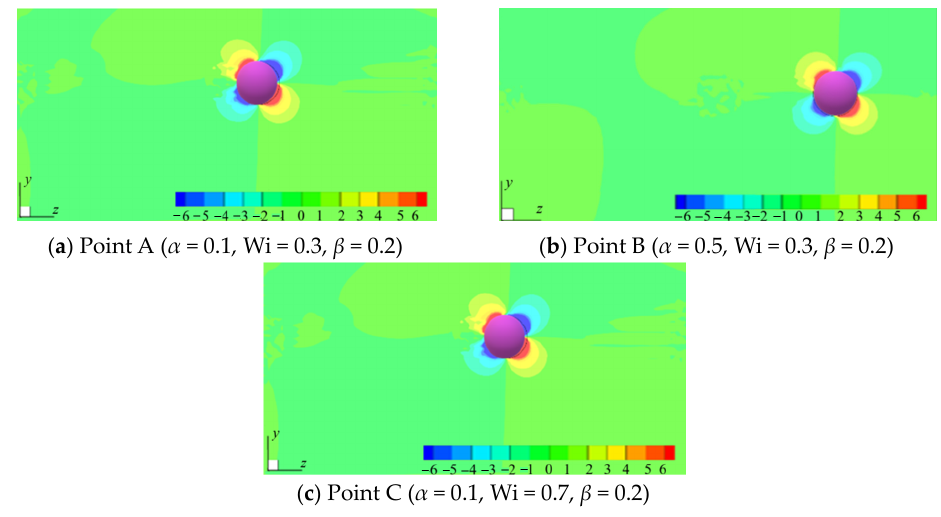
Figure 5. Pressure contours for three cases in Figure 3 ( µ r =0.7).